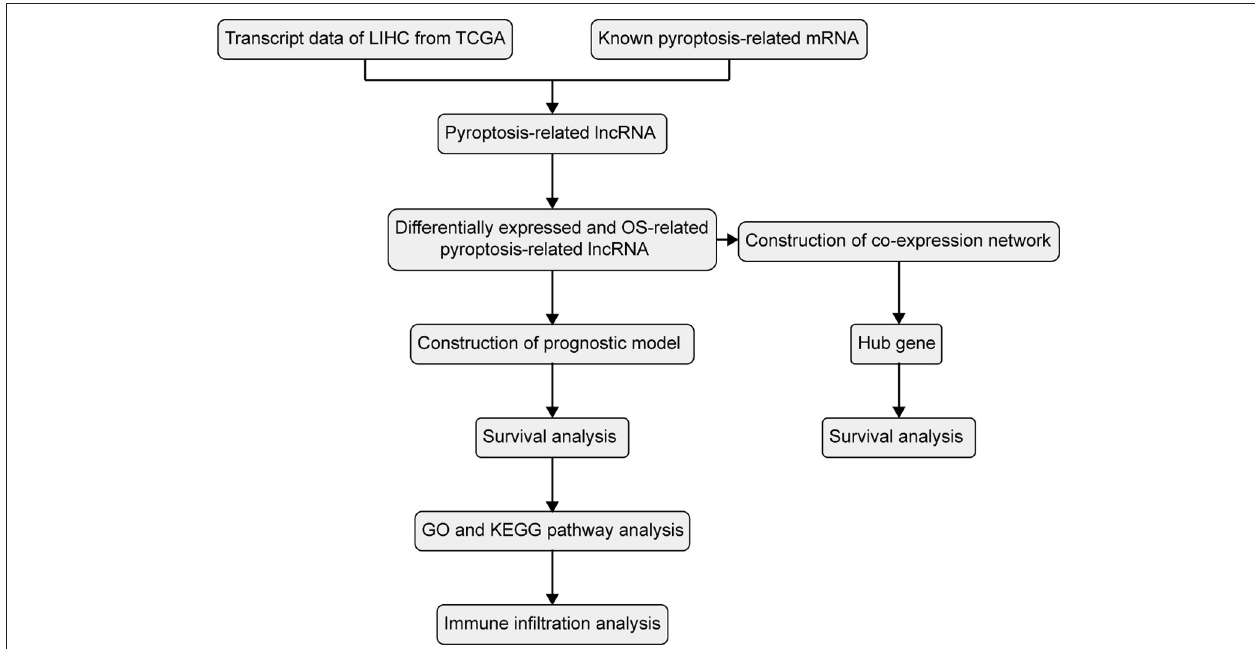
FIGURE 1 | Flowchart of construction and analysis of the prognostic model.